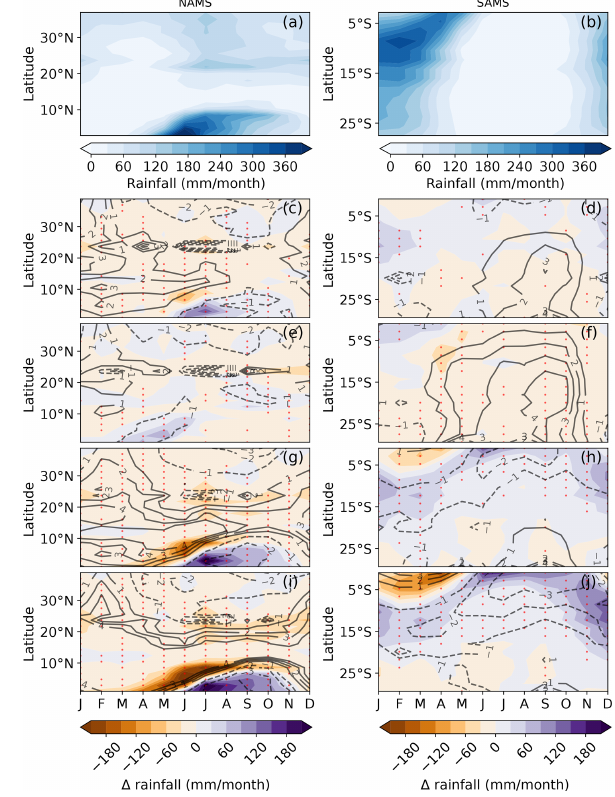
Figure 7. Hovmöller diagrams for the American continent domains. The left column corresponds to the NAMS do- main (a, c, e, g, i) and the right column to the SAMS do- main (b, d, f, h, j) . Panels (a, b) correspond to the precipitation val- ues in millimetres per month over the historical period (1976–2005). All other diagrams correspond to the difference between the fu- ture scenario (2041–2070) and the historical period (1976–2005) for precipitation (colours) and (cid:49) MSE (black contours, dashed lines for negative values). Future scenarios are (c, d) RCP8.5, (e, f) WAIS3m, (g, h) GrIS1m and (i, j) GrIS3m. Significant differences at the 95% confidence interval are depicted by red dots according to the Wilcoxon–Mann–Whitney test (see Sect. 2.3).